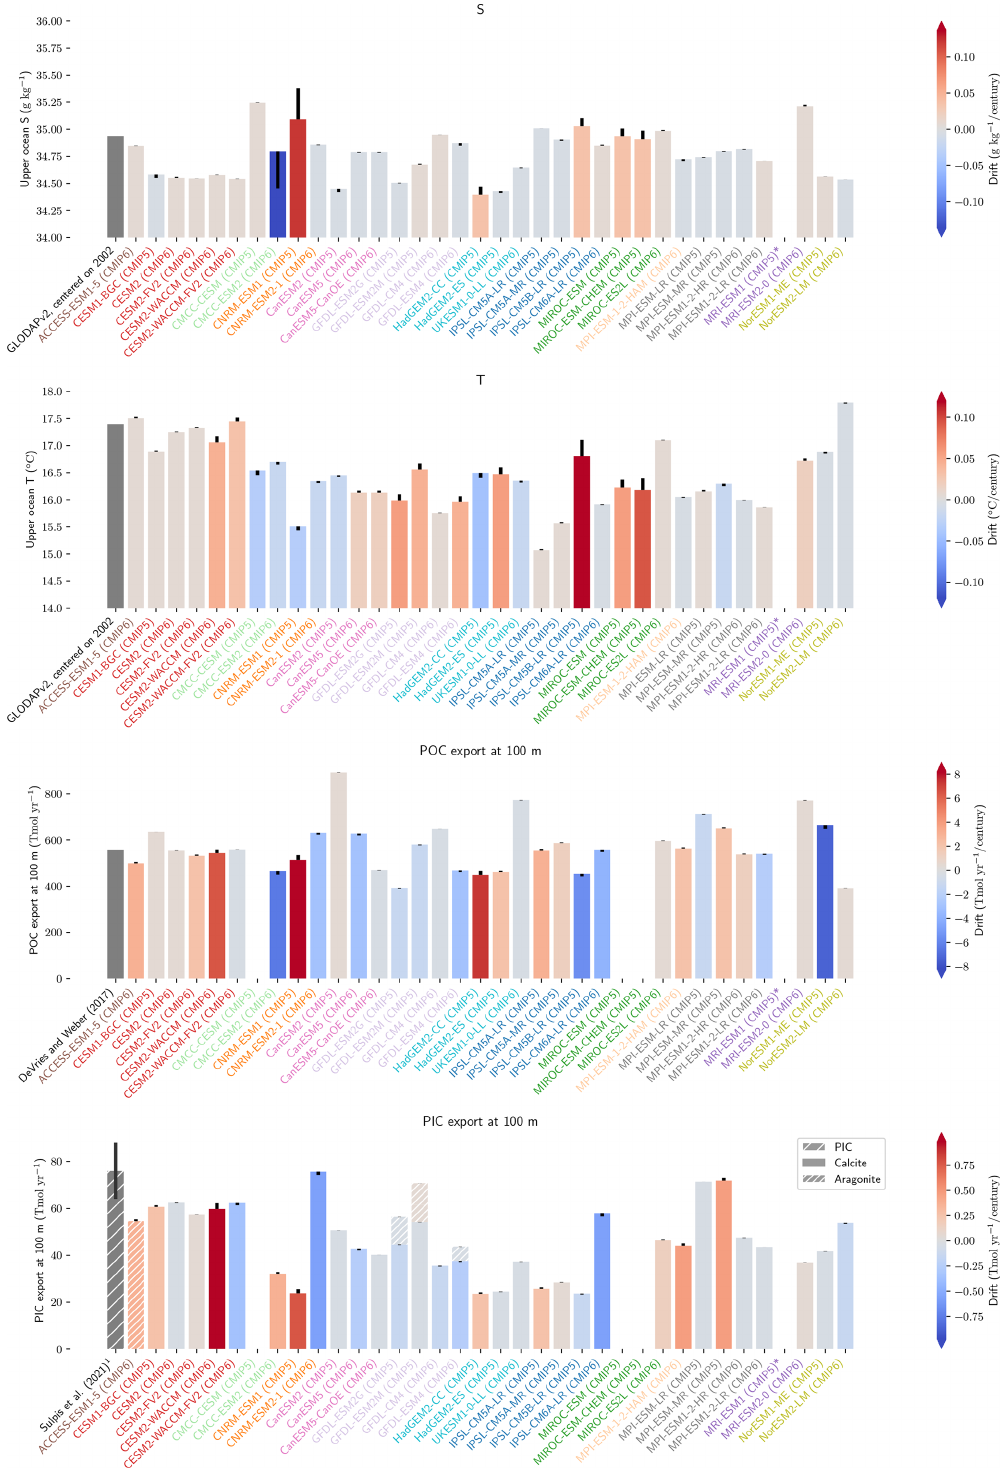
Figure D8. Additional CMIP5 and CMIP6 model drift evaluation (continuation of Fig. D7). Drift in upper (i.e. the first 100m) open-ocean salinity and temperature (averaged between the surface and 100m) as well as globally integrated POC and PIC (aragonite and calcite) export at 100m. For each panel, the first bar denotes the observational estimates with the associated standard deviation for PIC export ( 1 assessment at 300m). Bar height denotes the mean value in the first 20 years of the piControl (corresponding to 1850–1870), and the black bar denotes the mean value in the last 20 years of the piControl (corresponding to ∼ 2080–2100). Bar colour denotes model drift per century. Model names with an asterisk are not shown due to extreme drift relative to other models. piControl data for MRI-ESM1 (CMIP5) were not